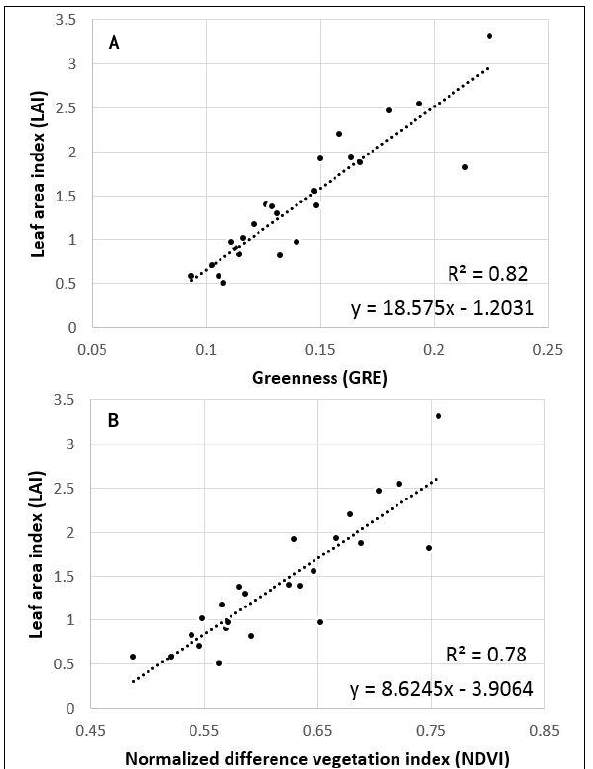
Figure 2. Linear regression of GRE (A) and NDVI (B) to LAI measurements at sample site G1.1.